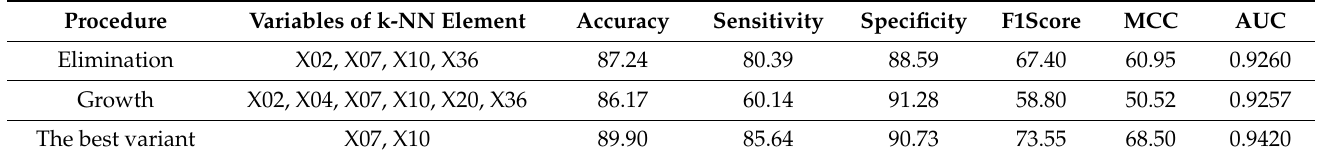
Table 7. Impact of curse of dimensionality on k-NN element.